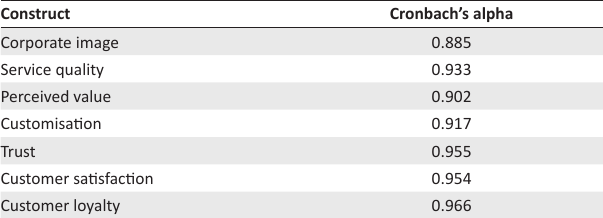
TABLE 1: Results of the Cronbach’s alpha test. Construct